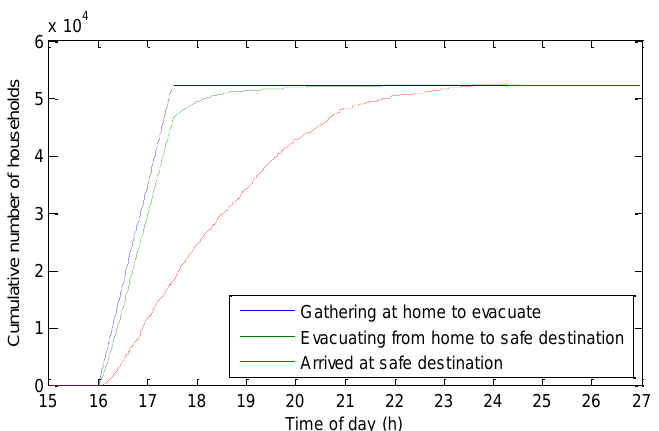
Figure 9. Evacuation progress over time for the Delft case study